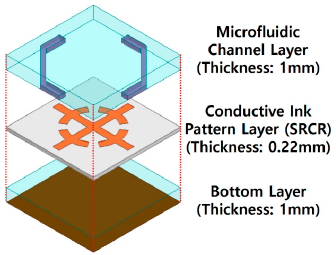
Figure 1. Three-dimensional view of unit cell design.